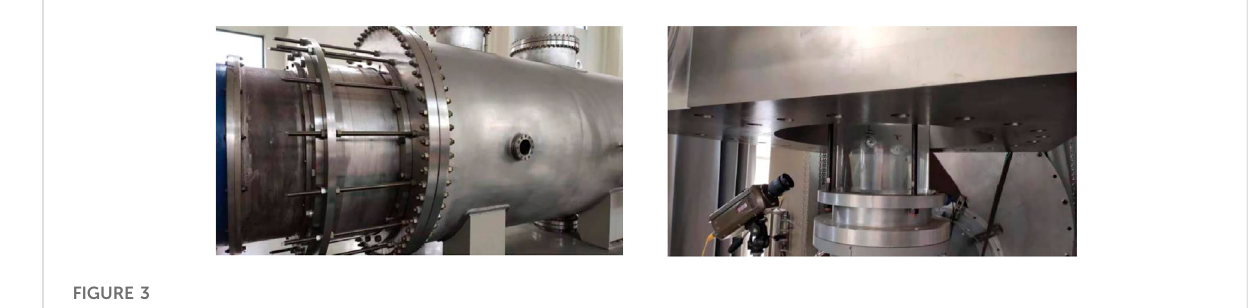
FIGURE 3 Experimental